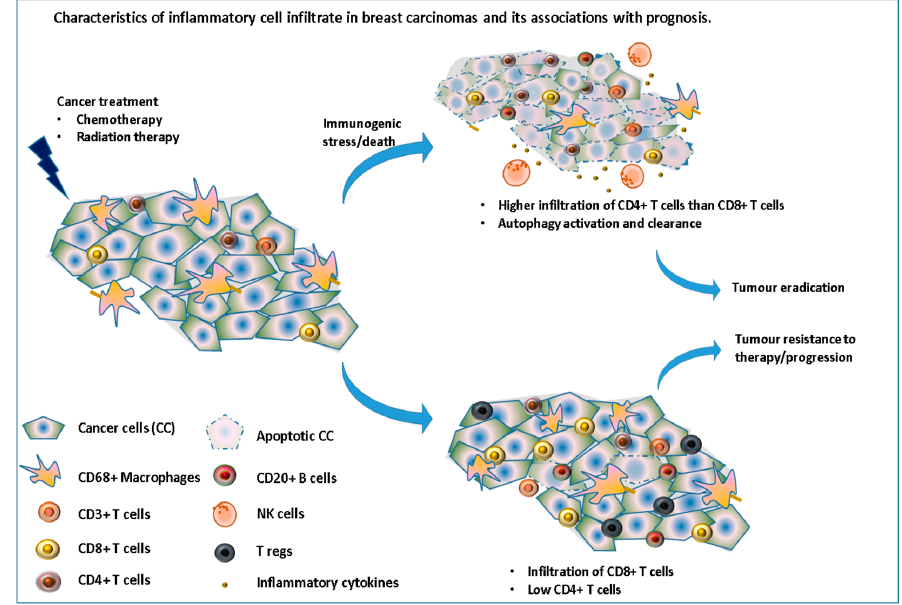
Figure 3. Immune cell infiltrate in breast carcinomas and its associations with prognosis.